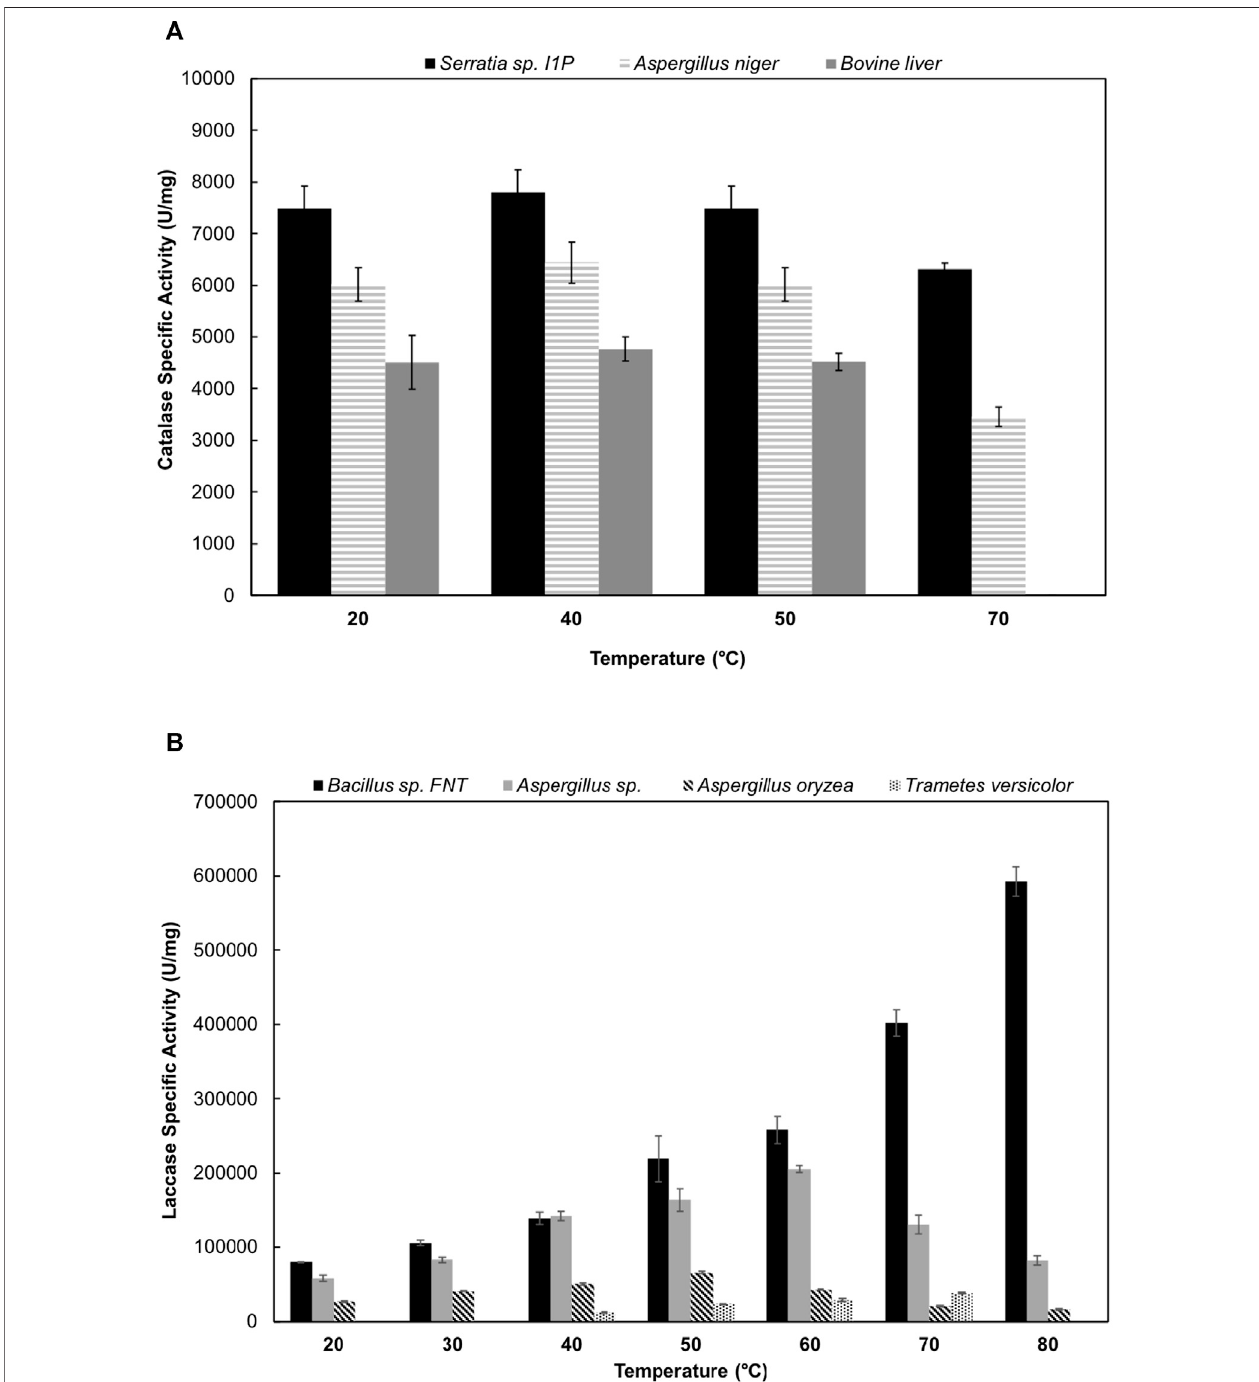
FIGURE 2 | Comparison of commercial catalases (A) and laccases (B) at different temperatures. Each commercial enzyme was assayed at their optimum pH, as reported by each manufacturer in their data sheets. The enzyme assays used were described in the method section for each enzyme. One unit (U) of CAT activity was de fi nedasthedecompositionof1 µmolofH 2 O 2 perminute.Oneunit(U)oflaccaseactivitywasde fi nedasachangeinabsorbanceat530 nmof0.001perminute,under the assay conditions. Error bars indicate standard deviation of triplicate measurements.